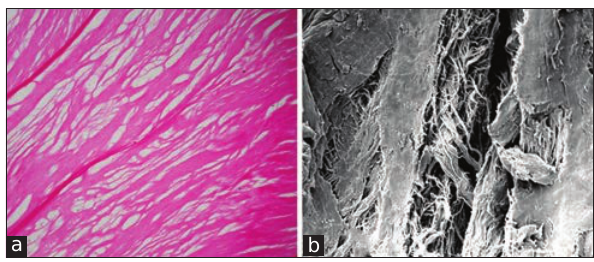
Figure-3: (a) Decellularized fish swim bladder showing loss of cellularity and dense fiber architecture providing adequate porosity (hematoxylin and eosin stain, ×40), (b) scanning electron microscopy observation showing loss of cellularity and dense fiber architecture providing adequate porosity (×3000).